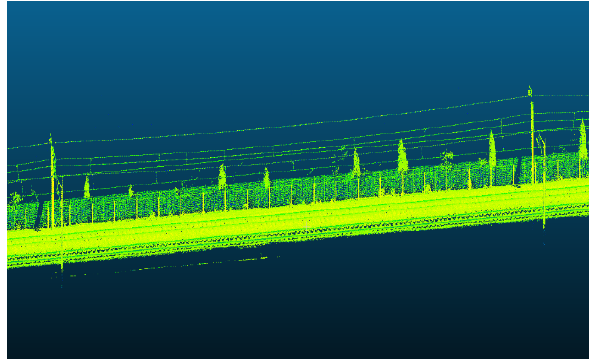
Figure 3. Protective